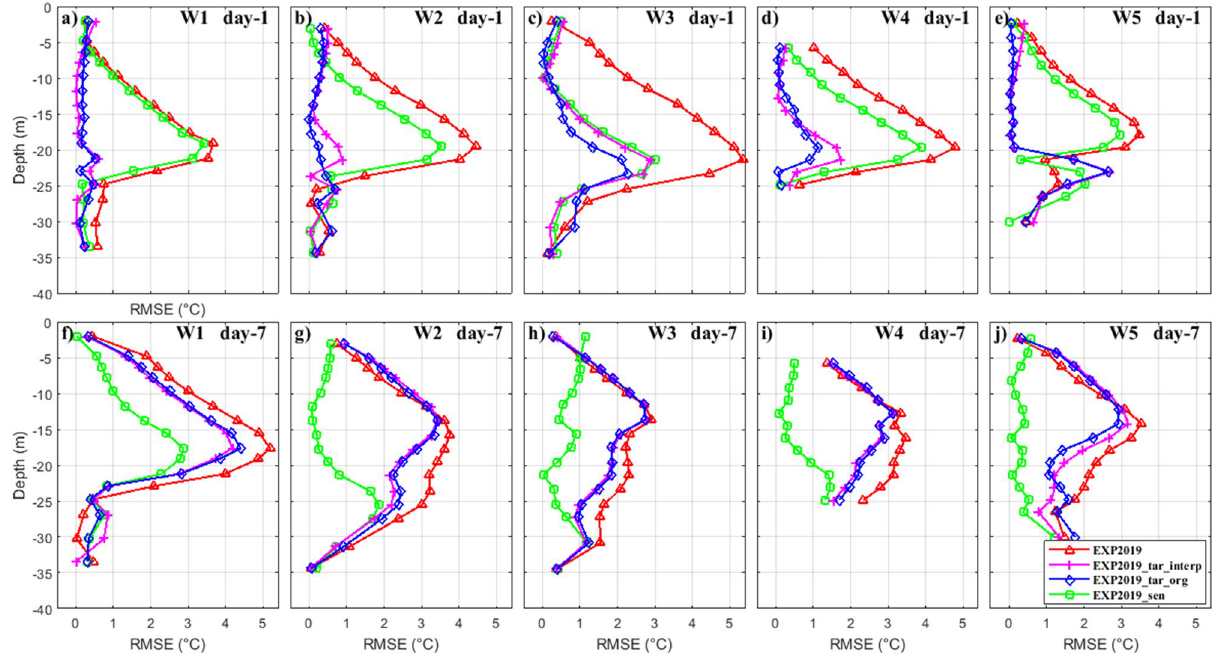
Figure 8. The RMSEs of daily averaged temperature profiles at five buoys between the four Observing System Experiments and the observations on the first ( a – e ) and 7th ( f – j ) day of prediction, respectively. Figures are plotted using MATLAB R2017a (http:// www. mathw orks.